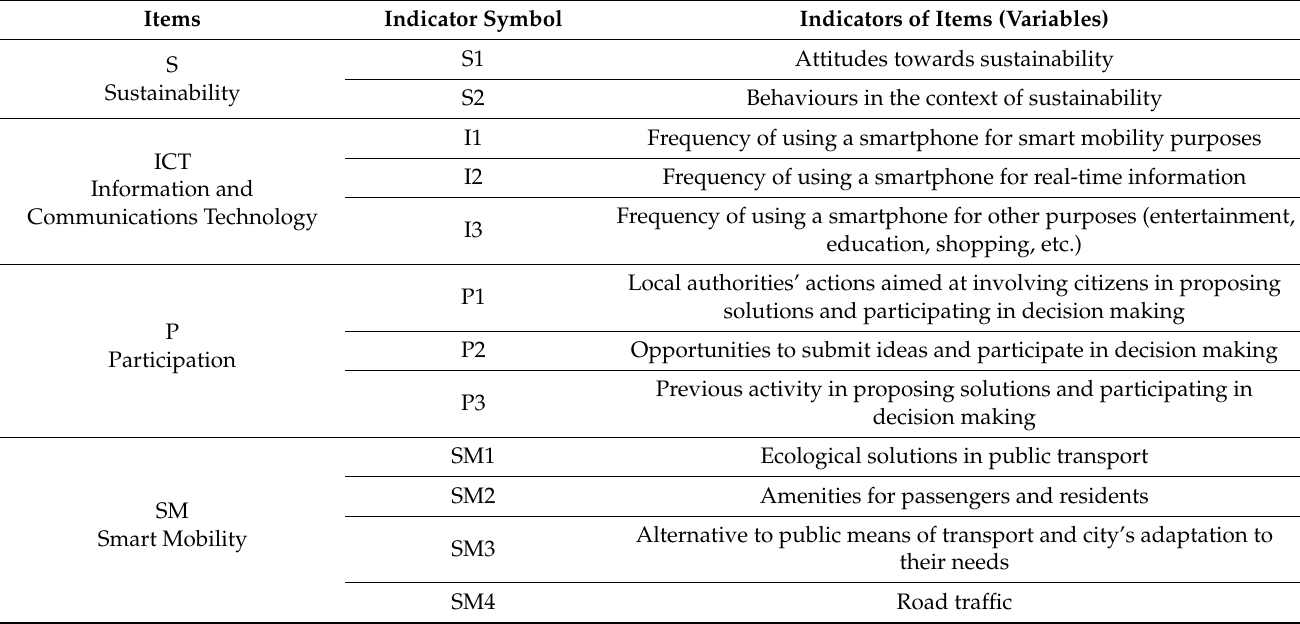
Table A1. Items and indicators of items used in the